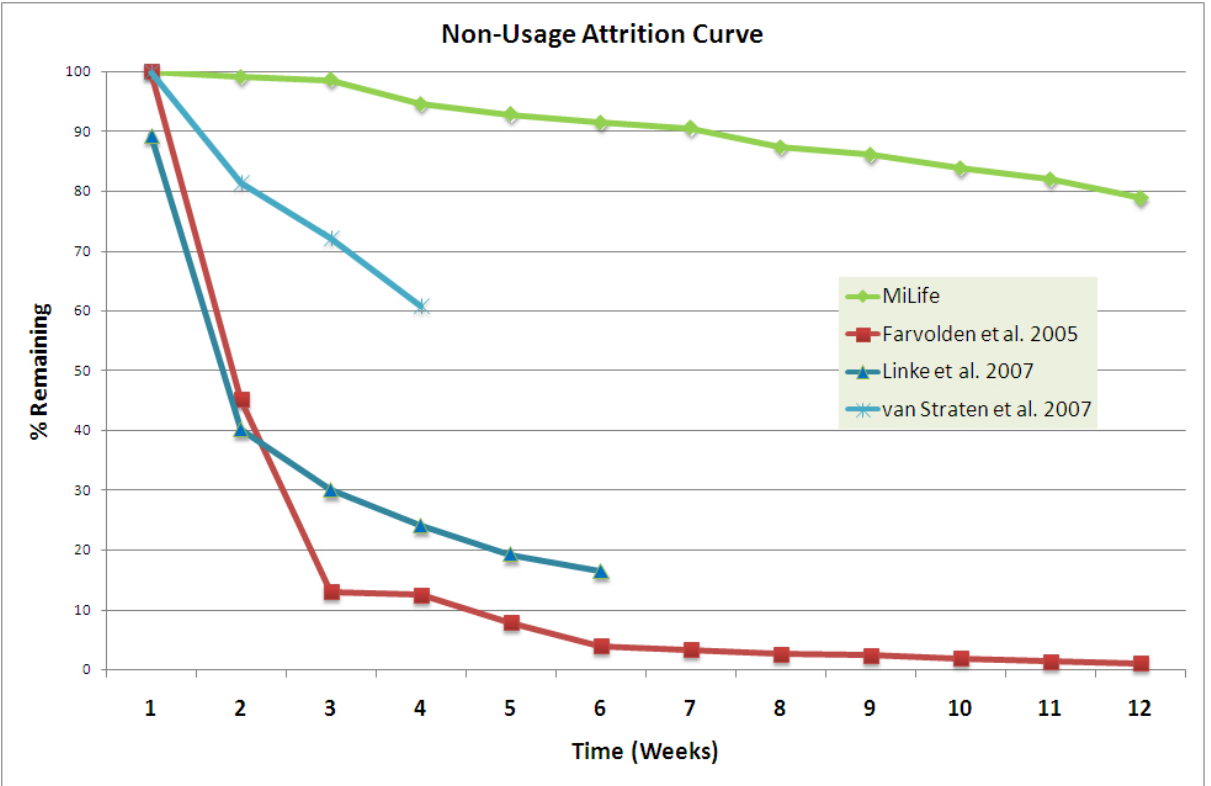
Figure 2. Nonusage attrition curves [27] for MiLife and Farvolden et al [31], Linke et al [32], and van Straten et al [33] eHealth